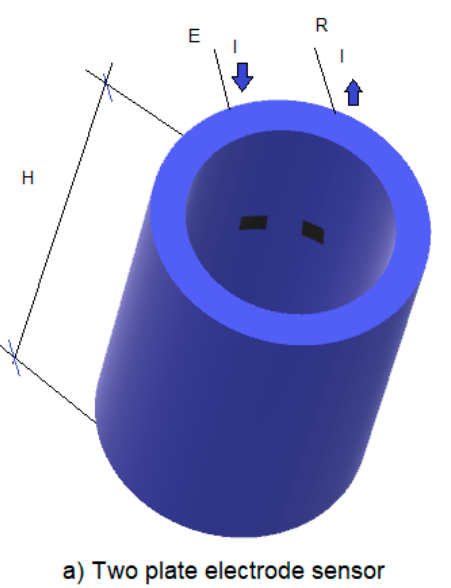
Figure 2. ( a ) Conductance probe of two plate electrode configuration with the pipe full of water; ( b ) notation and location of the electrodes in cylindrical coordinates.